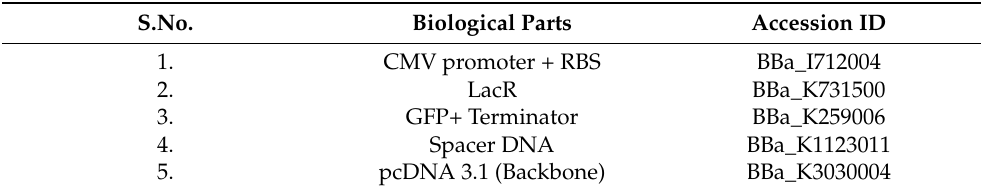
Table 2. Registry of standard biological parts with parts registry number (Sequences of the same enlisted in Supplementary Material